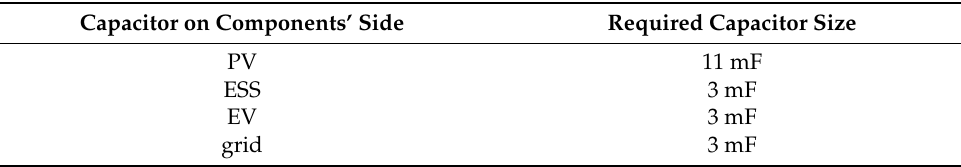
Table 2. required capacitor’s size for voltage fluctuation below ± 5%.